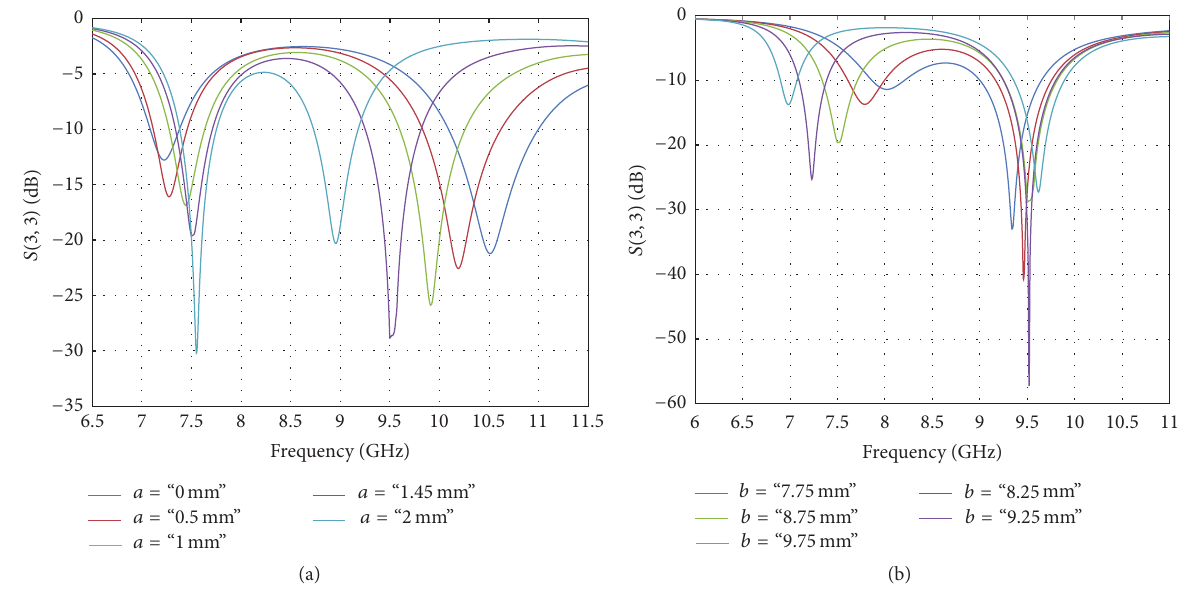
Figure 24: Reflection coefficients of the second NB antenna for (a) slot length variations and (b) microstrip stub length